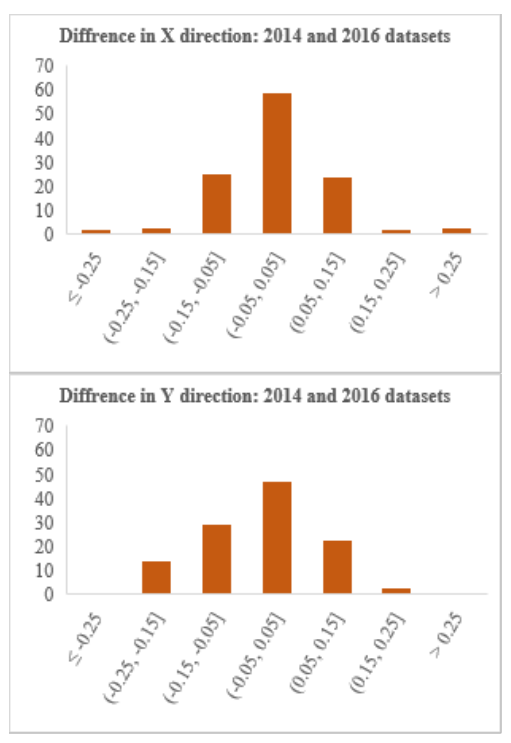
Figure 3. Histograms of residuals between planimetric coordinates measured on both oblique image datasets.